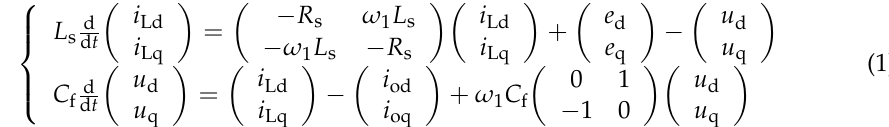
layer is not discussed.